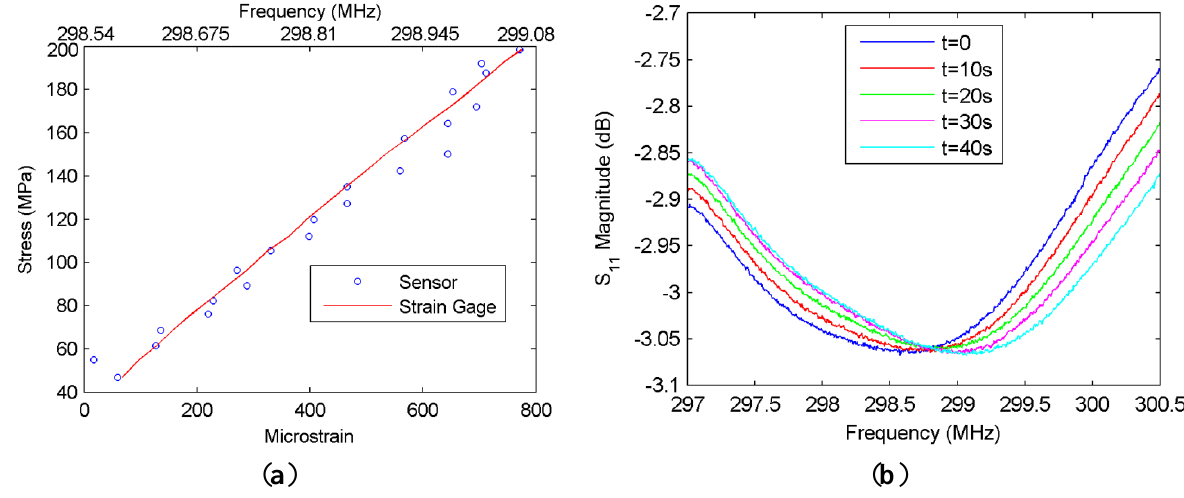
Figure 7. ( a ) Stress versus microstrain characteristics, experimentally measured by the sensor, in comparison to the average of the strain gage readings for an 8-mm diameter rebar pulled in a high-force mechanical setup. Corresponding resonance frequencies are also displayed on the upper horizontal-axis; ( b ) Shift of the frequency minima over time as the force is linearly increased, which is used to plot